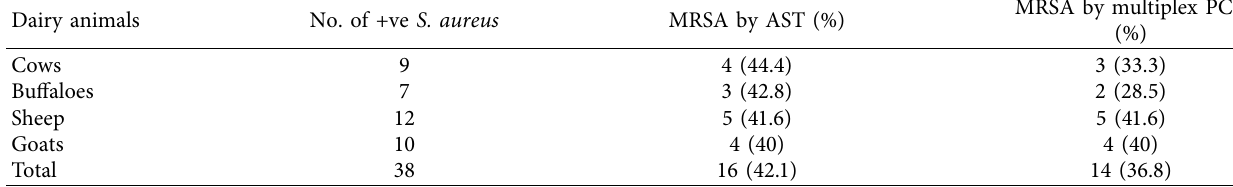
Table 5: Evaluation of S. aureus and MRSA causing mastitis in animals by multiplex PCR and AST. Dairy animals No. of +ve S. aureus